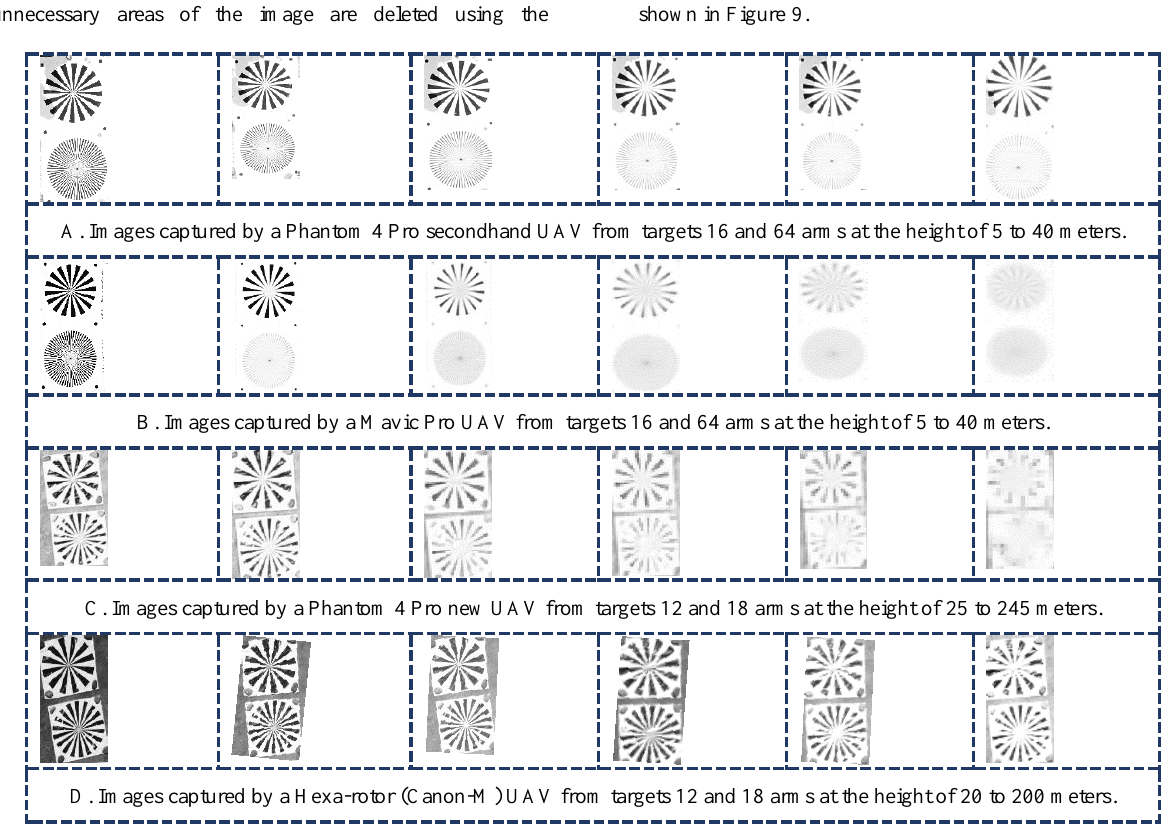
Figure 9. Targets detected by the proposed method and unnecessary image sections